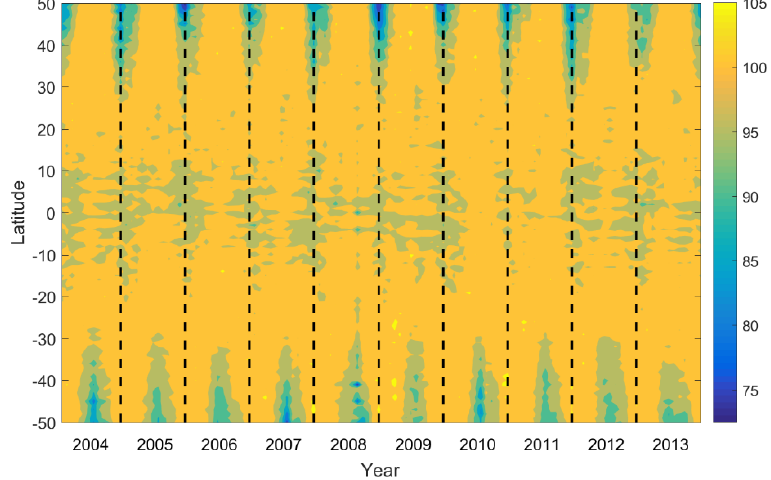
Figure 7. Distribution of the PHA for gravity waves along with latitude from 2004 to 2013.